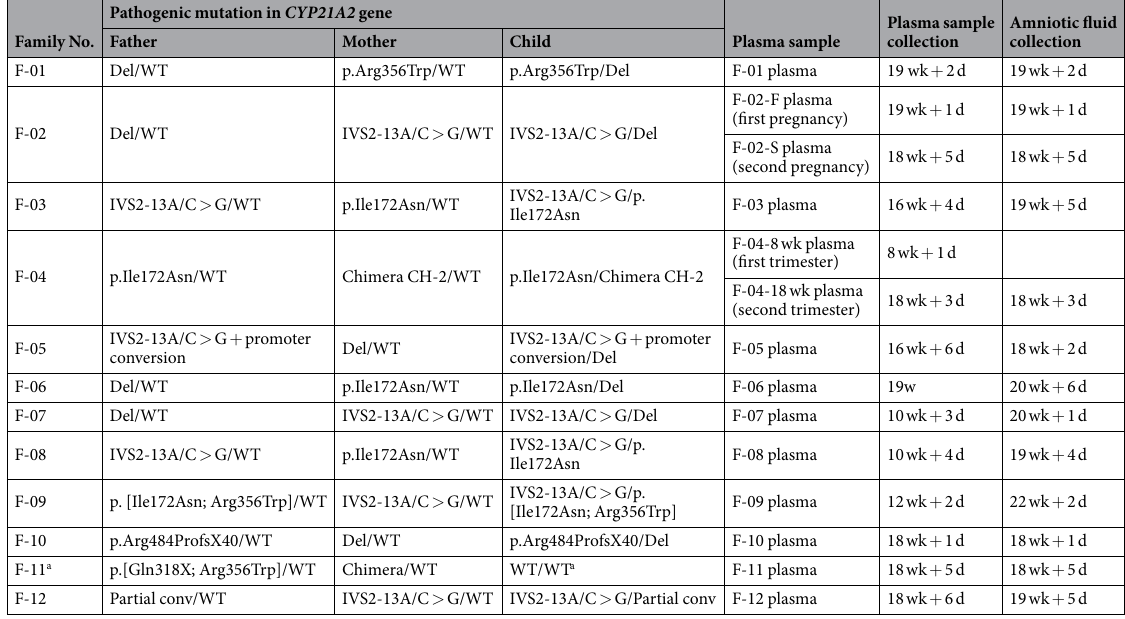
Table 1. Overview of the studied families. a The parents were referred to our clinic for prenatal diagnosis because their first two children died shortly after birth due to CAH. Abbreviantions: WT: wild-type allele; Chimera: CH-2, which possesses the CYP21A1P gene from exon 1 to exon 4; Partial conv: Cluster E6, p.Val281Leu, p.Leu307PhefsX6, and p.Arg356Trp